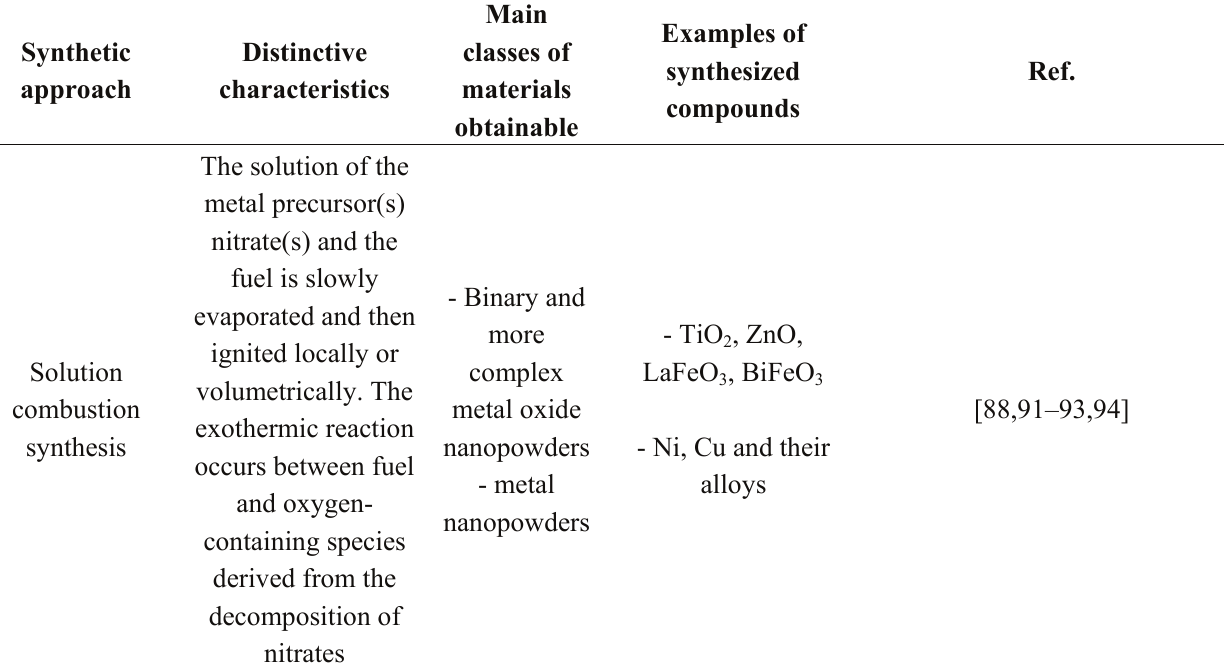
Table 3. Summary of some of the latest modifications of combustion synthesis for the preparation of engineered